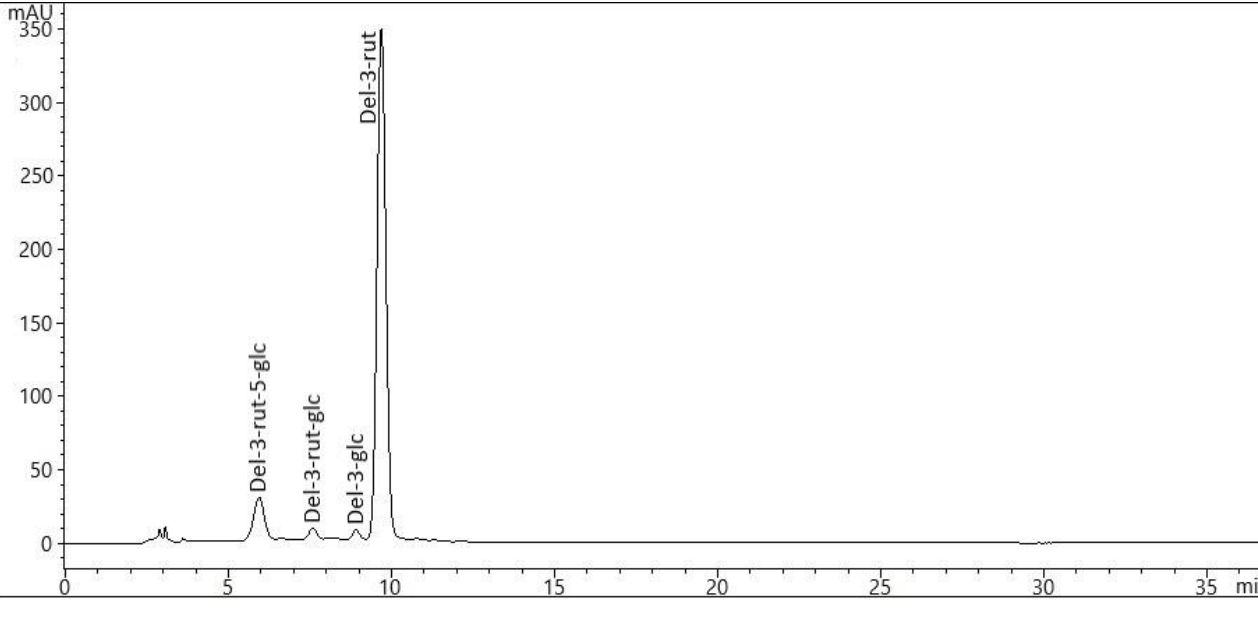
Figure 1. HPLC-DAD chromatograms of anthocyanins ( λ = 525 nm) in the peel and pulp of eggplant fruits (‘Aydin Siyahi’, ‘Kadife Kemer’ and ‘Trabzon Kadife’). Del-3-rut-5-glc: delphinidin-3-rutinoside-5-glucoside; Del-3-rut-glc: delphinidin-3-rutinoside-glucoside; Del-3-glc: delphinidin-3-glucoside; Del-3-rut: delphinidin-3-rutinoside. Table 4. HPLC chromatographic characteristics and delphinidin-3- O -rutinoside (del-3-rut) concentra- tions (mg/kg fw) in fruits of common eggplants using HPLC-DAD/ESI-MS χ .